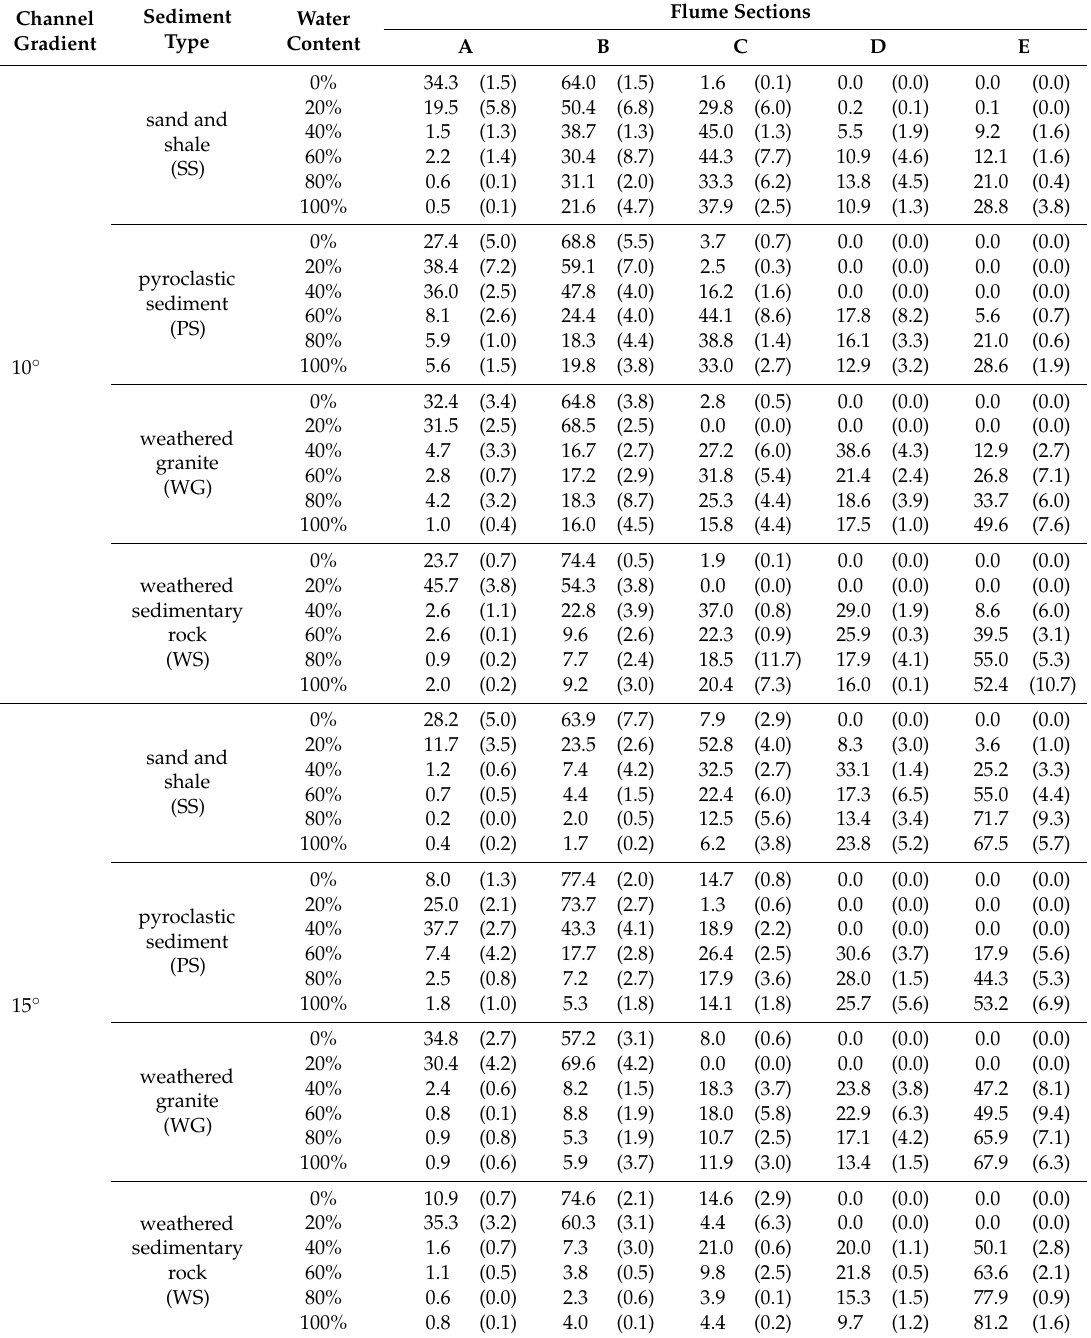
Table A4. Summary of sediment deposition for 90 ◦ inflow angle (in %). Values in parentheses indicate standard